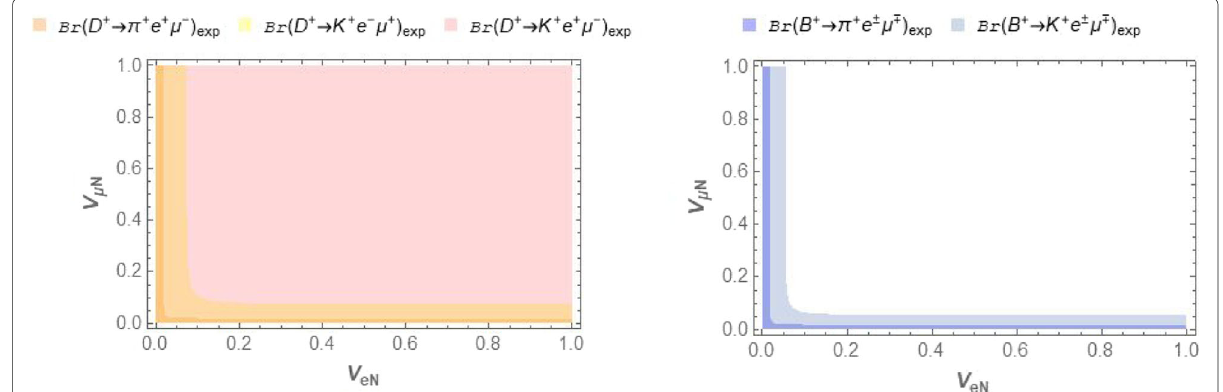
Fig. 5 The allowed parameter space in scenario B, in which we have taken m N = 1.5GeV as an